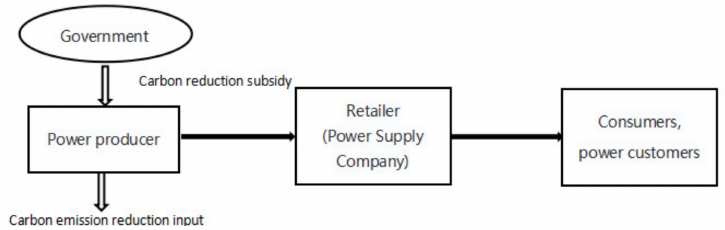
Figure 1. Schematic diagram of model D.